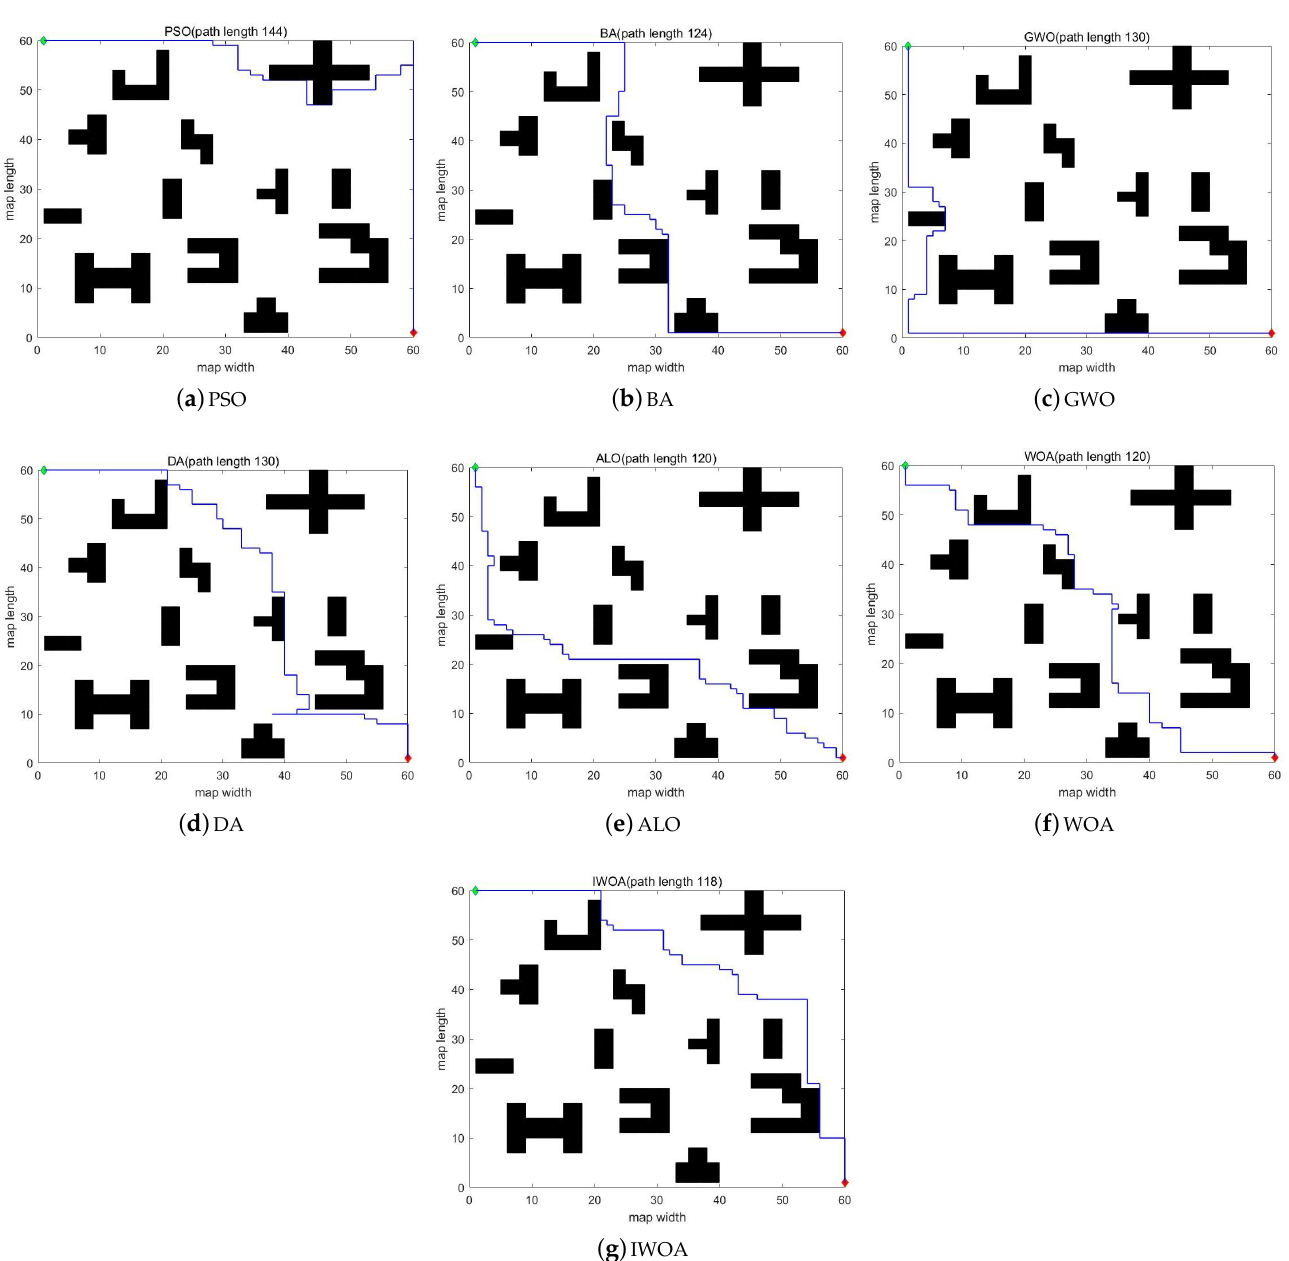
Figure 16. Actual path traces of seven different algorithms on 60 × 60 size